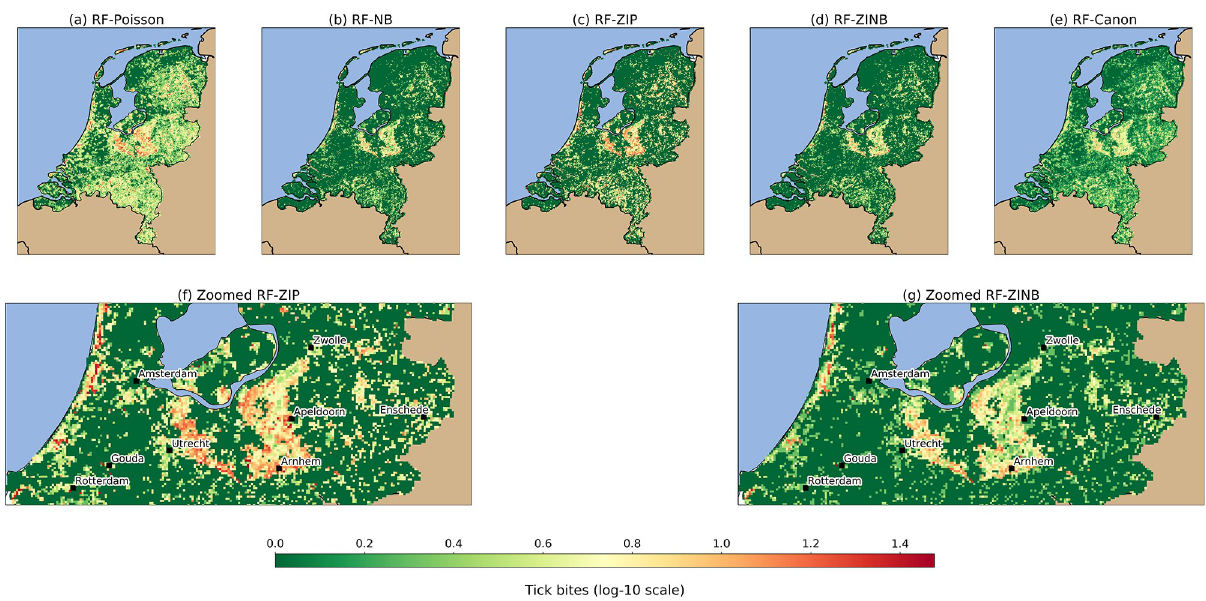
Fig 8. Tick bite risk maps produced by combining RF with each of the count data models. The logarithmic (log-10) scale corresponds to the range of 0–30 predicted tick bites per grid cell. The upper row (a-e) shows the general overview of the models, whereas the bottom row shows a close-up for the ZIP (f) and ZINB (g) models. The NB (b) and ZINB (d) models are better suited to delineate regions with low or inexistent tick bite risk, thus they present sharper declines between different land uses. The ZIP (c) model is capable of predicting the risk of tick bite over a range of values, this is why its associated map presents smooth and gradual changes across the study area. POI (a) and RF (e) are over/under predicting, respectively, since the former finds risk in most locations of the country, whereas the latter yields and almost-homogeneous prediction. The visual inspection of the zoomed models (f, g) identify popular places for recreation intensely visited by citizens. The forested areas between Utrecht, Apeldoorn, and Arnhem, together with the recreational areas along the coast are regions where tick bite risk is particularly high.